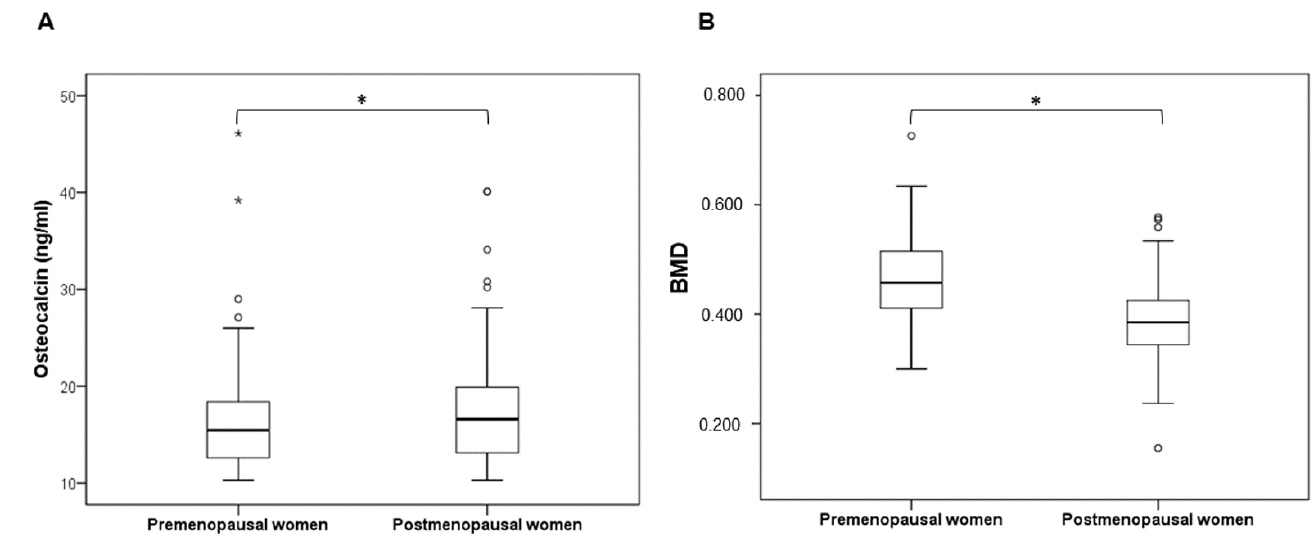
Figure 3. Box plots of ( A ) OC and ( B ) BMD levels in premenopausal and postmenopausal euthyroid women. * Denotes a significant p -value of a t -test at the significance level of 0.05. Outliers are marked with circles, while extreme outliers are marked with asterisks.